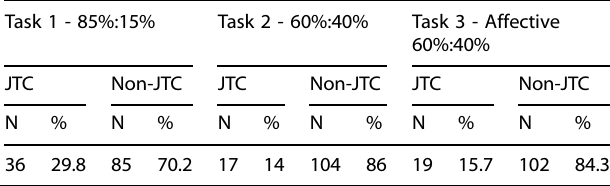
Table 2. Percentages of participants who jump to conclusions and those who do not in each bead